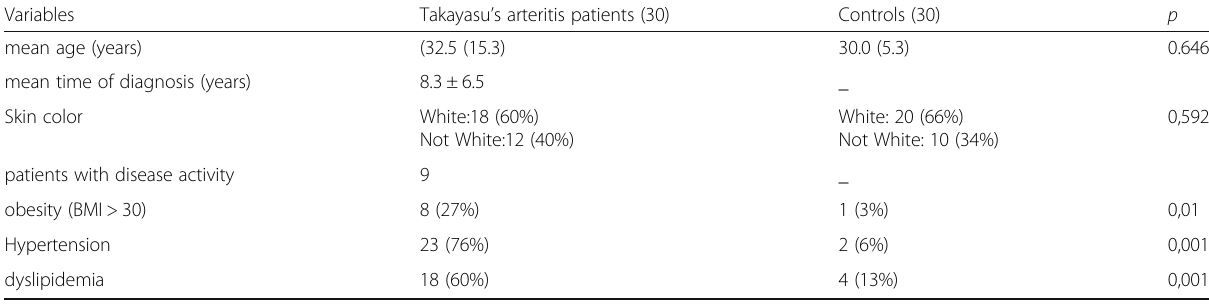
Table 1 Demographic and clinical characteristics of the Takayasu ’ s arteritis patients and controls